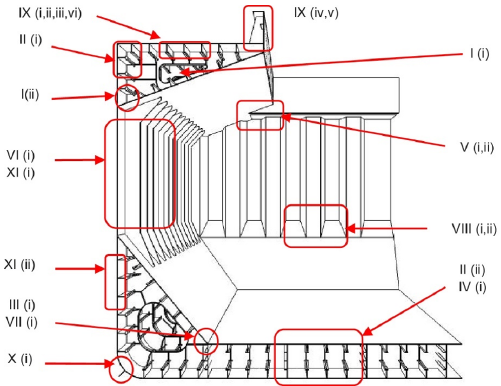
Figure 1. Structural areas prone to fractures in bulk carriers